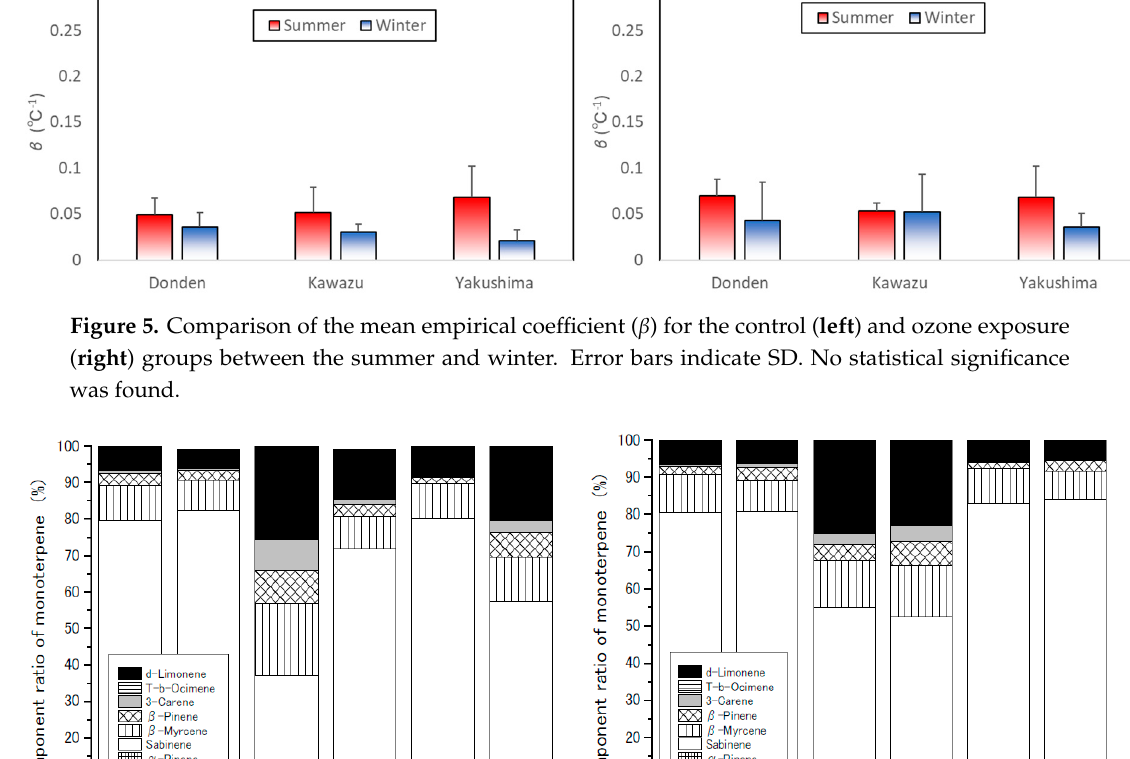
Figure 5. Comparison of the mean empirical coefficient ( 𝛽 ) for the control (left) and ozone exposure (right) groups between the summer and winter. Error bars indicate SD. No statistical significance was found.